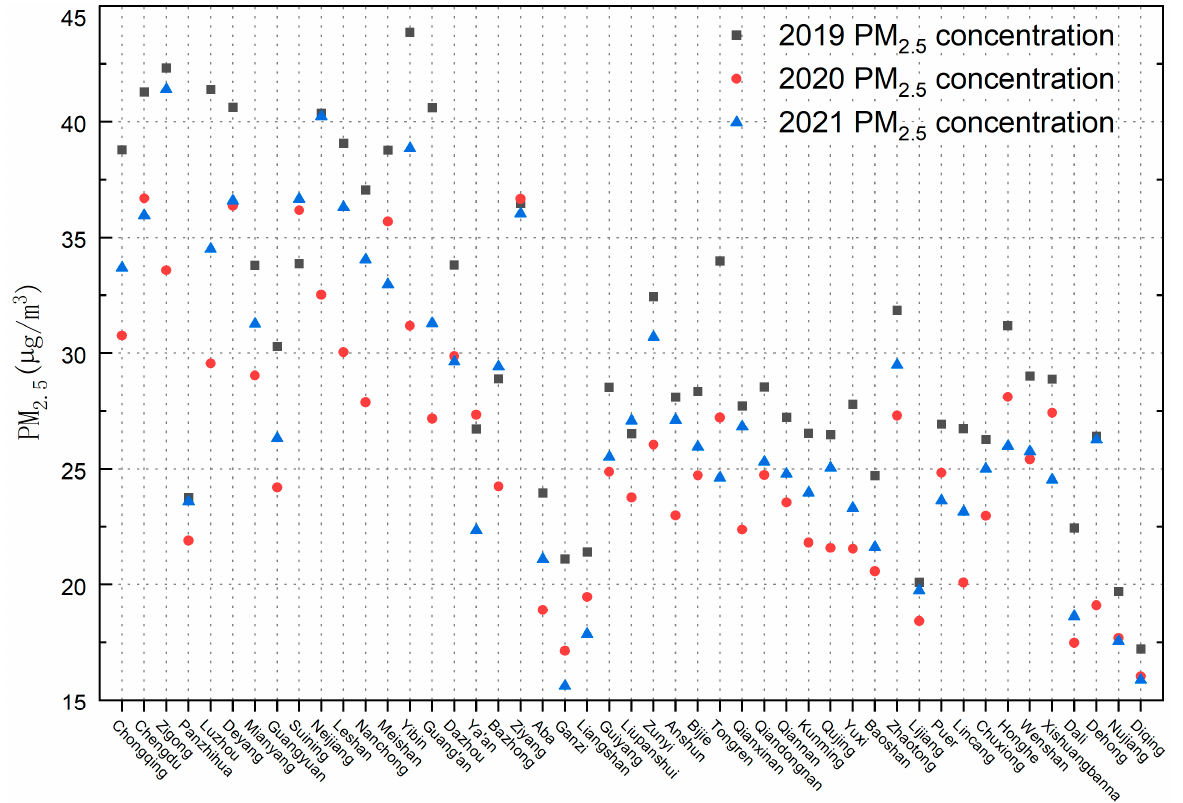
Figure 6. Annual change in PM 2.5 concentration in cities in southwest China.